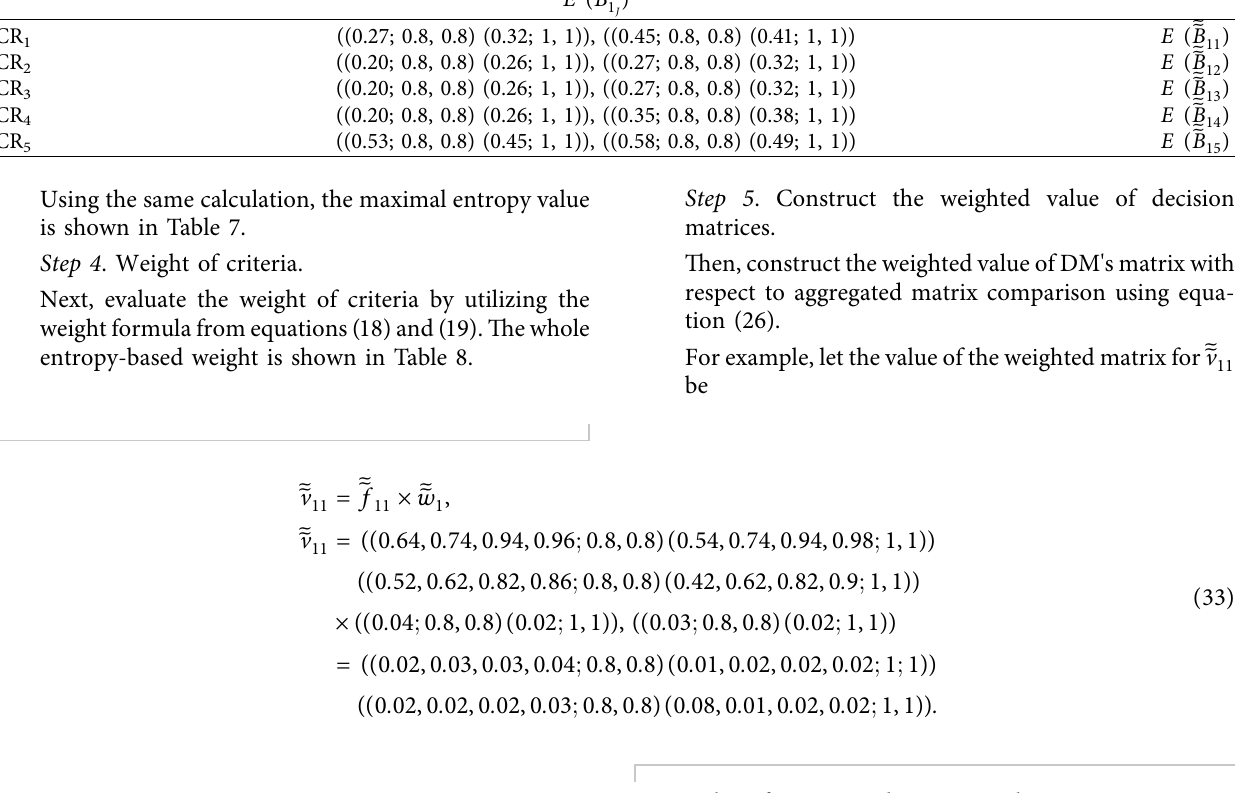
Table 6: Choosing the maximal entropy value for E ( 􏽥􏽥 B